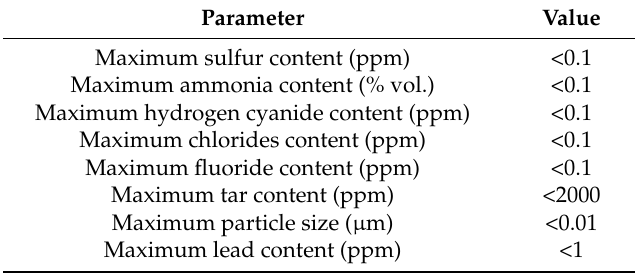
Table 3. Pollutant limits for Molten Carbonate Fuel Cells (MCFC) type fuel cells